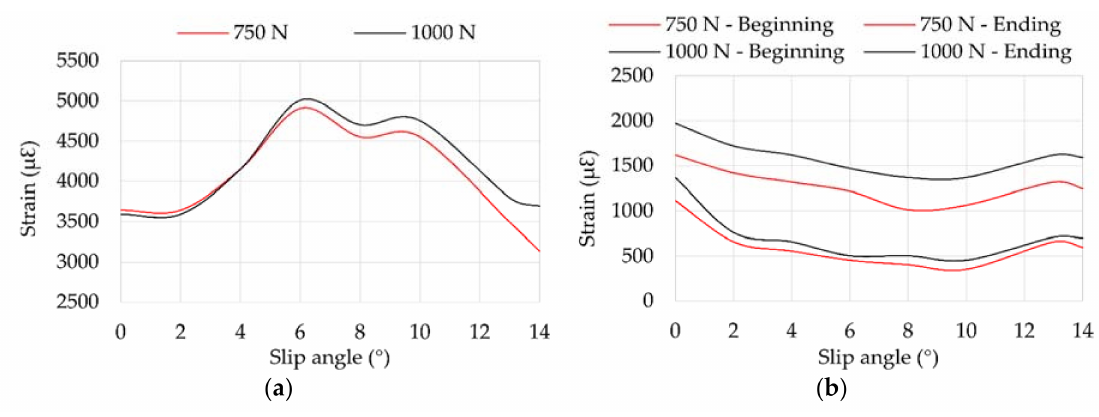
Figure 14. ( a ) Maximum strain peaks in channel 2 ( ε x ) at 0.8 bar, 30 km/h; ( b ) Maximum strain peaks in channel 3 ( ε y1 ) at 0.8 bar, 30 km/h.